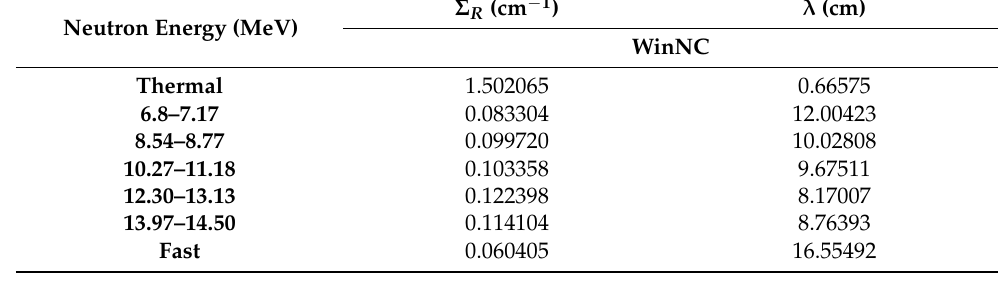
Table 7. The neutron removal cross-sections and mean free paths of PSU using WinNC.